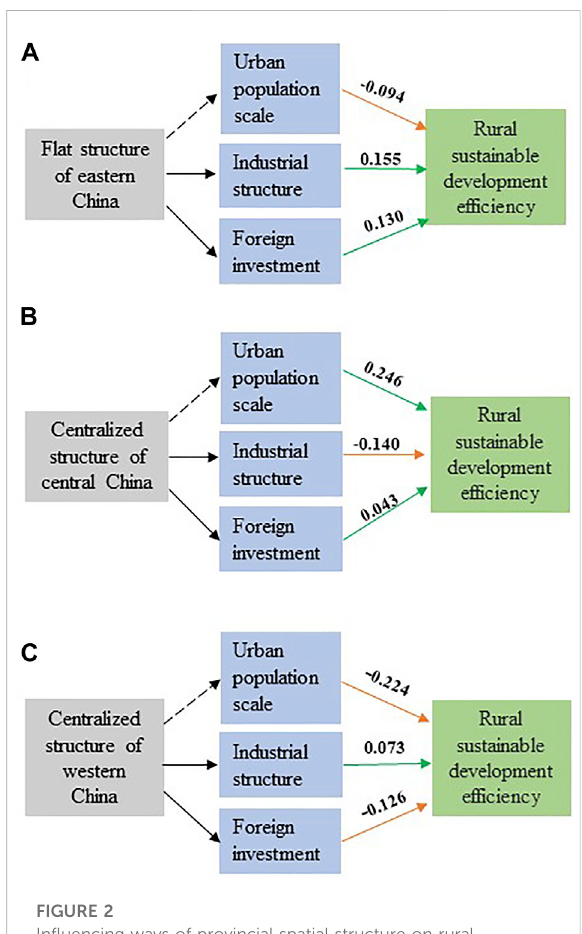
FIGURE 2 In fl uencing ways of provincial spatial structure on rural sustainable development. Note: The value is the coef fi cient of an interaction term between spatial structure and corresponding